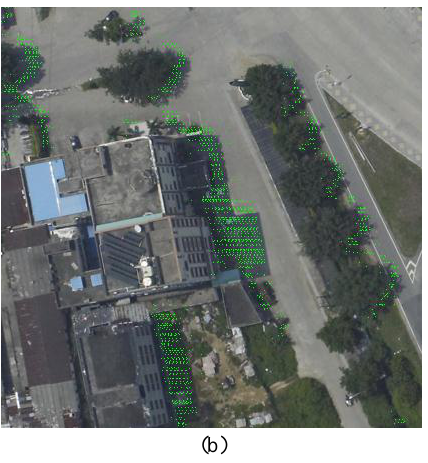
Figure 5. Shadow